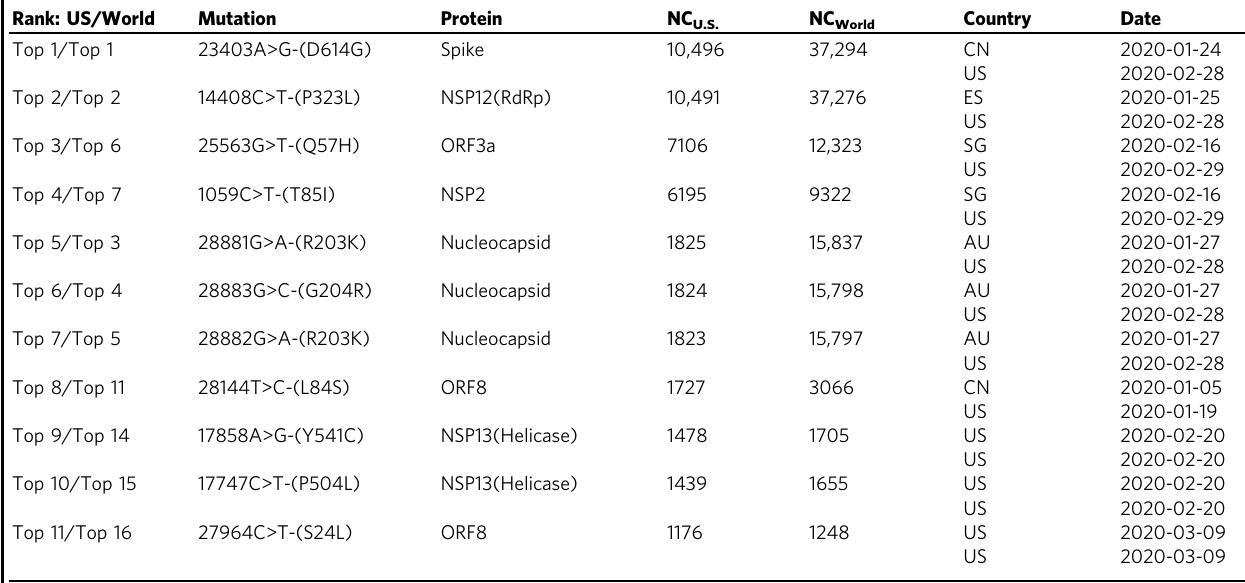
Table 1 Top 11 missense mutations that are prevalent in the United